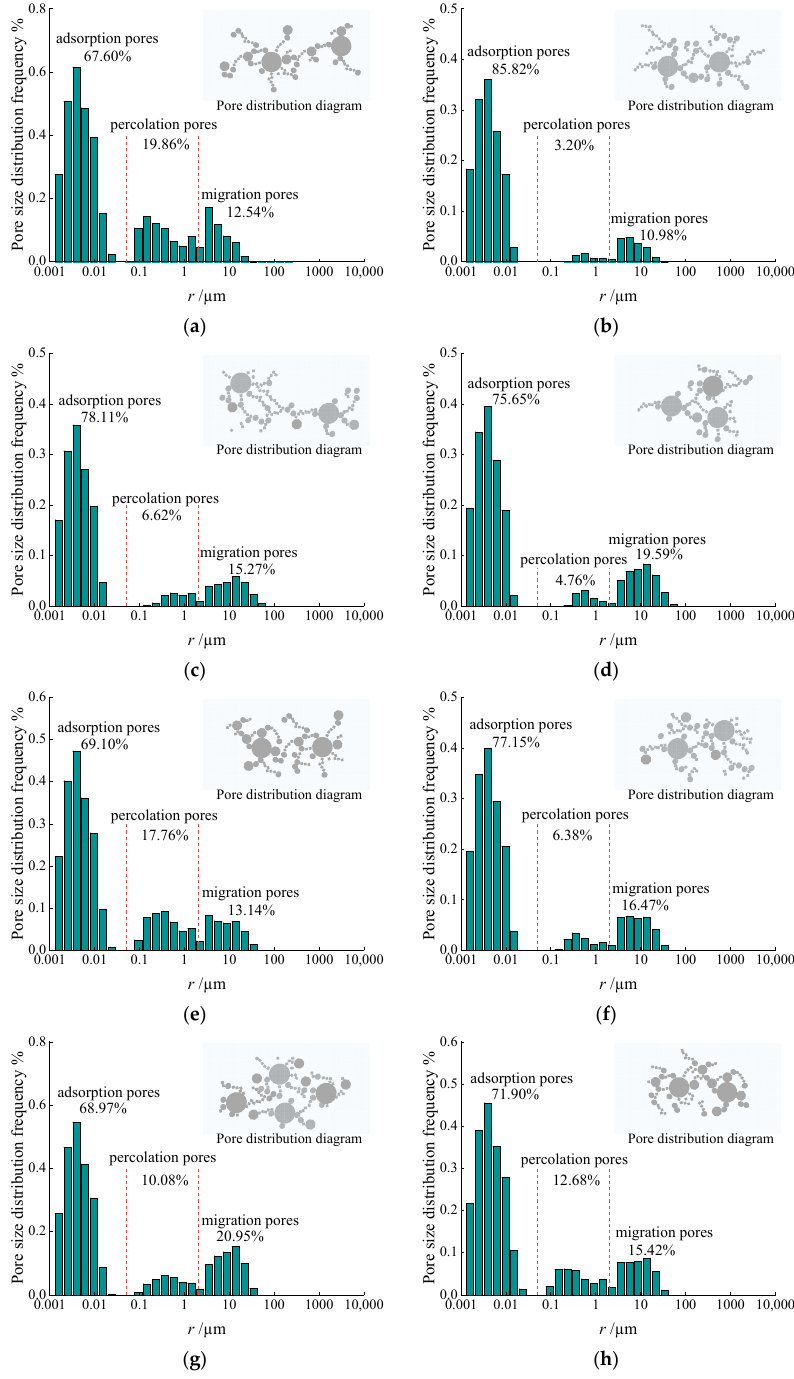
Figure 9. Pore size distribution of coal samples: ( a ) sample A; ( b ) sample B; ( c ) sample C; ( d ) sample D; ( e ) sample E; ( f ) sample F; ( g ) sample G; ( h ) sample